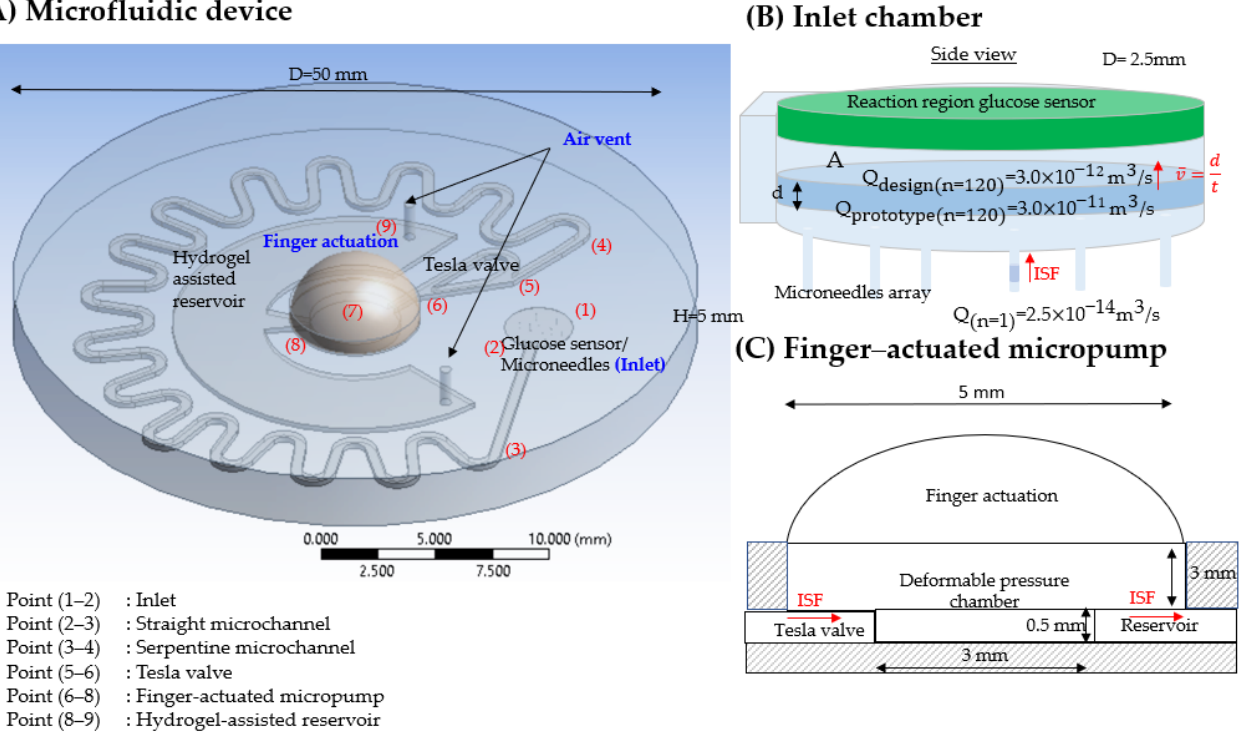
Figure 1. Schematic illustration of the micro fl uidic device: ( A ) General overview; ( B ) Inlet connected with sensor and microneedle array; ( C ) Finger actuated micropump. (Points (1)–(9) indicated the point-to-point components in the micro fl uidic system, and the red arrow indicated ISF moving fl ow) Table 1. Geometry of design and prototype of micro fl uidic system.